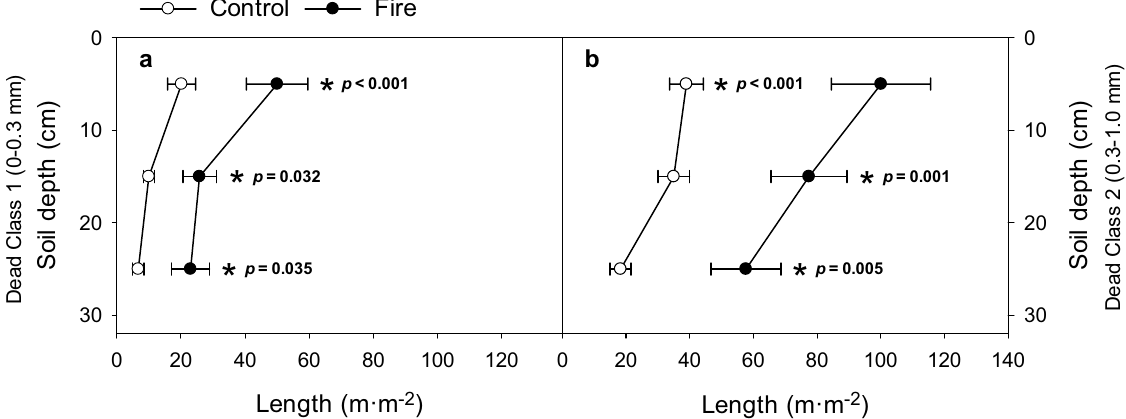
Figure 4. The significant interactions of fire × soil depth on dead fine root length (m·m −2 ) for Root Class 1 (0–0.3 mm) ( a ) and Root Class 2 (0.3–1.0 mm) ( b ). For control ( ○ ; n = 40) and fire-affected ( ● ; n = 30) trees, significant differences ( p < 0.05) determined by paired t-test and shown in bold with an